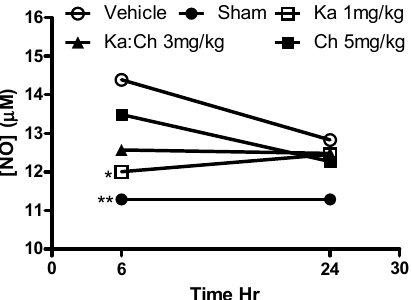
Figure 9. Time course profile of kaempferol and chrysin individual and combination treatments on serum nitrite levels in septic mice determined fluorometrically using 2,3-diaminonaphthalene (DAN). Each point represents the mean of four experiments. * p ≤ 0.05 and ** p ≤ 0.01 versus CLP/vehicle (Student’s t -test).